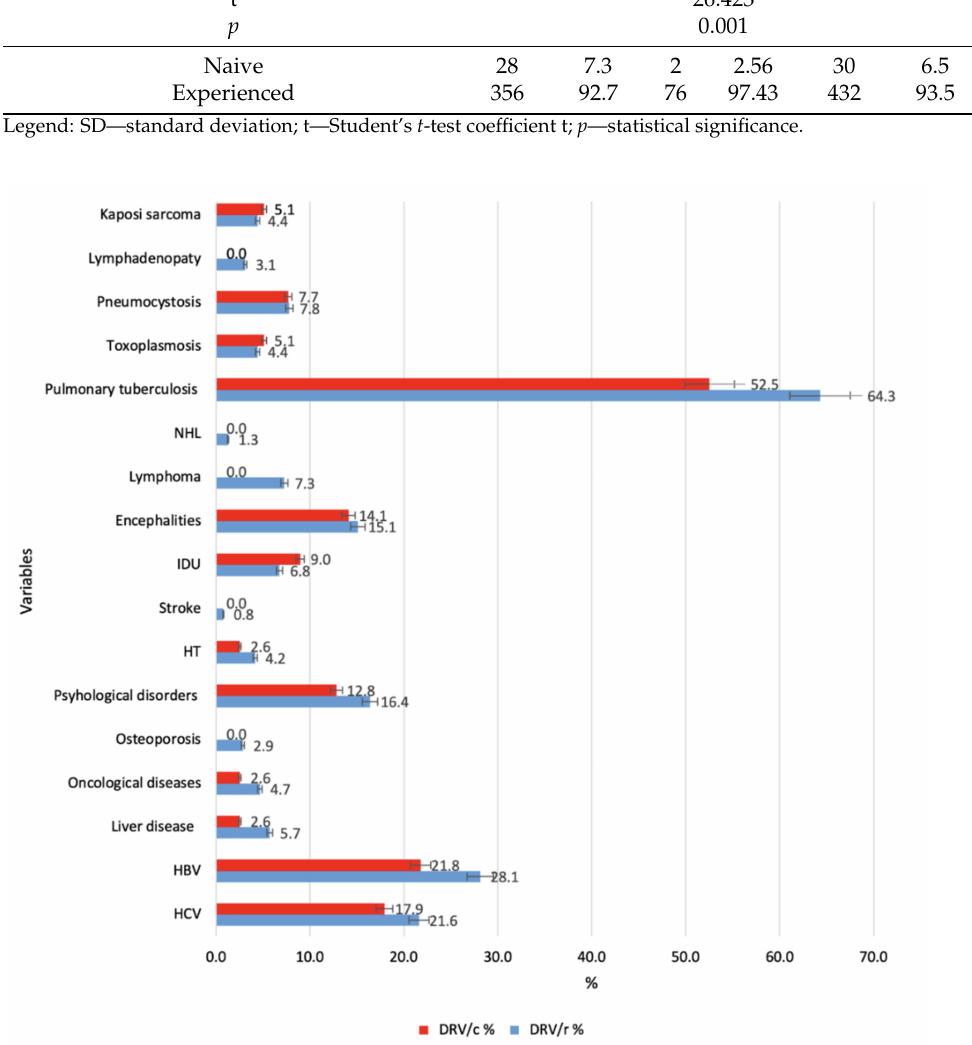
Figure 1. HIV-1 related comorbidities compared to the two groups (defined clustered bar: summaries of group of cases (% of cases). Legend: NHL—non-Hodgkin lymphoma; IDU—injection drug use; HT—hypertension; HBV—hepatitis B virus; HCV—hepatitis C